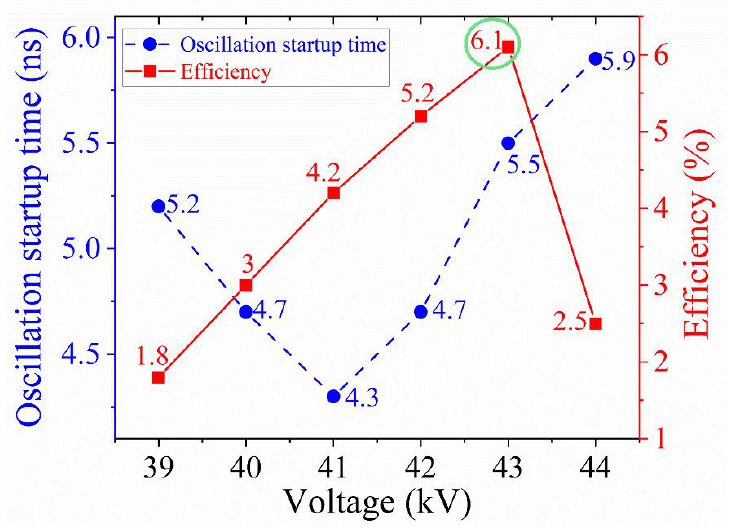
Figure 7. The EIO’s oscillation startup time and efficiency versus electron beam voltage.